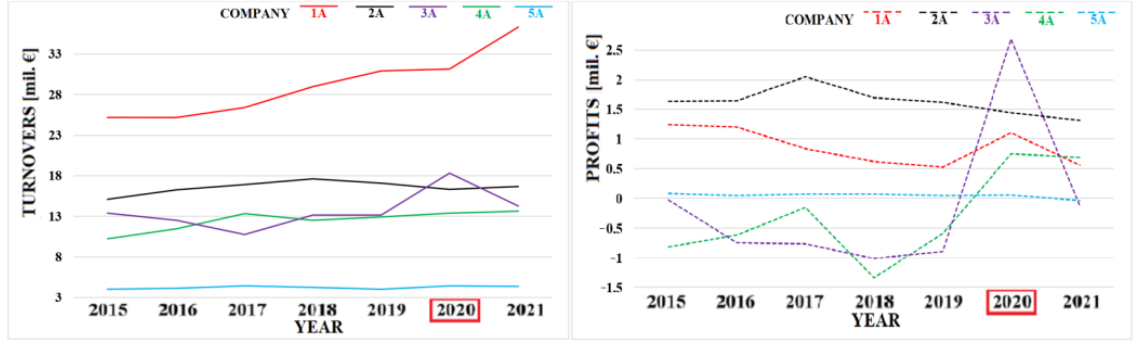
Figure 10. Development of turnovers and profits of the largest Slovak producers of alcoholic beverages [56].